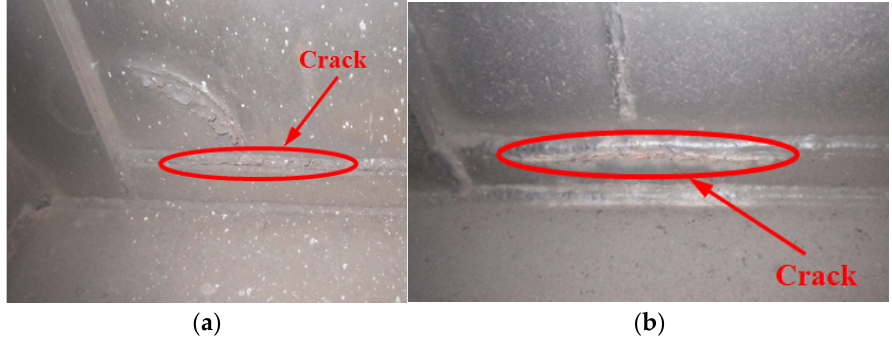
Figure 1. ( a ) The crack on cross bearer weld of 70t gondola car body; ( b ) The crack on cross bearer weld of 80t gondola car body.